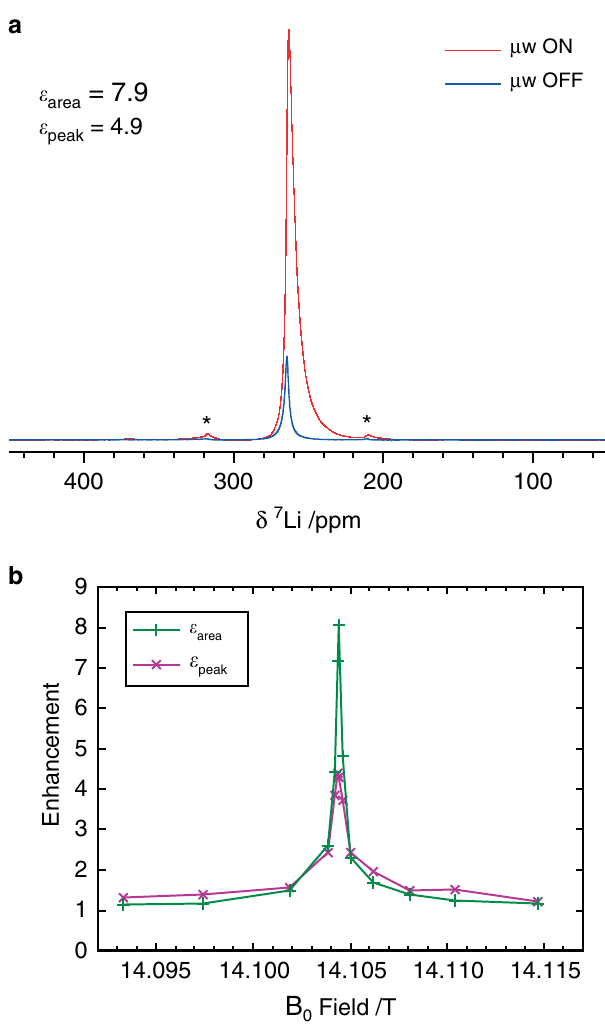
Fig. 2 DNP enhancement of Li metal. a 7 Li NMR spectrum of microstructural lithium metal (sample A), with and without 15.6 W of microwave irradiation at 395.29 GHz ( μ w ON/OFF), recorded at 14.1045 T, 12.5 kHz MAS and a sample temperature of ~300 K, using a Hahn echo pulse sequence, a recycle delay of 0.25 s and 80 scans. Spinning sidebands are marked with an asterisk. b The enhancement of the integrated intensity and peak intensity as a function of the B 0 fi eld (sample B), measured at 100